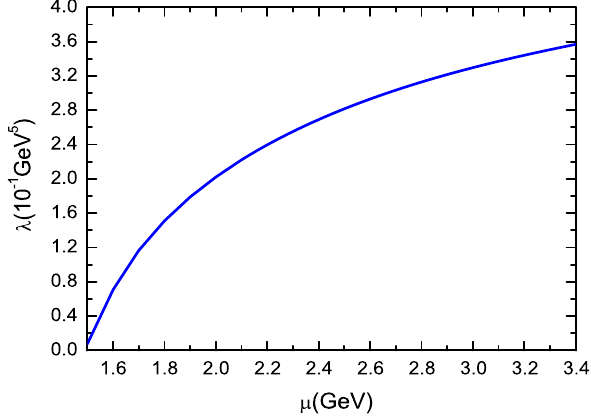
residue λ X ( cc ¯ c ¯ c , 0 ++ ) increases monotonously and quickly with increase of the energy scale μ at the region μ ≥ 1 . 6 GeV, no stable QCD sum rules can be obtained; see Fig. 9. So the QCD sum rules cannot be saturated by the meson pairs η c η c , J /ψ J /ψ plus a scalar tetraquark state X ( cc ¯ c ¯ c , 0 ++ )